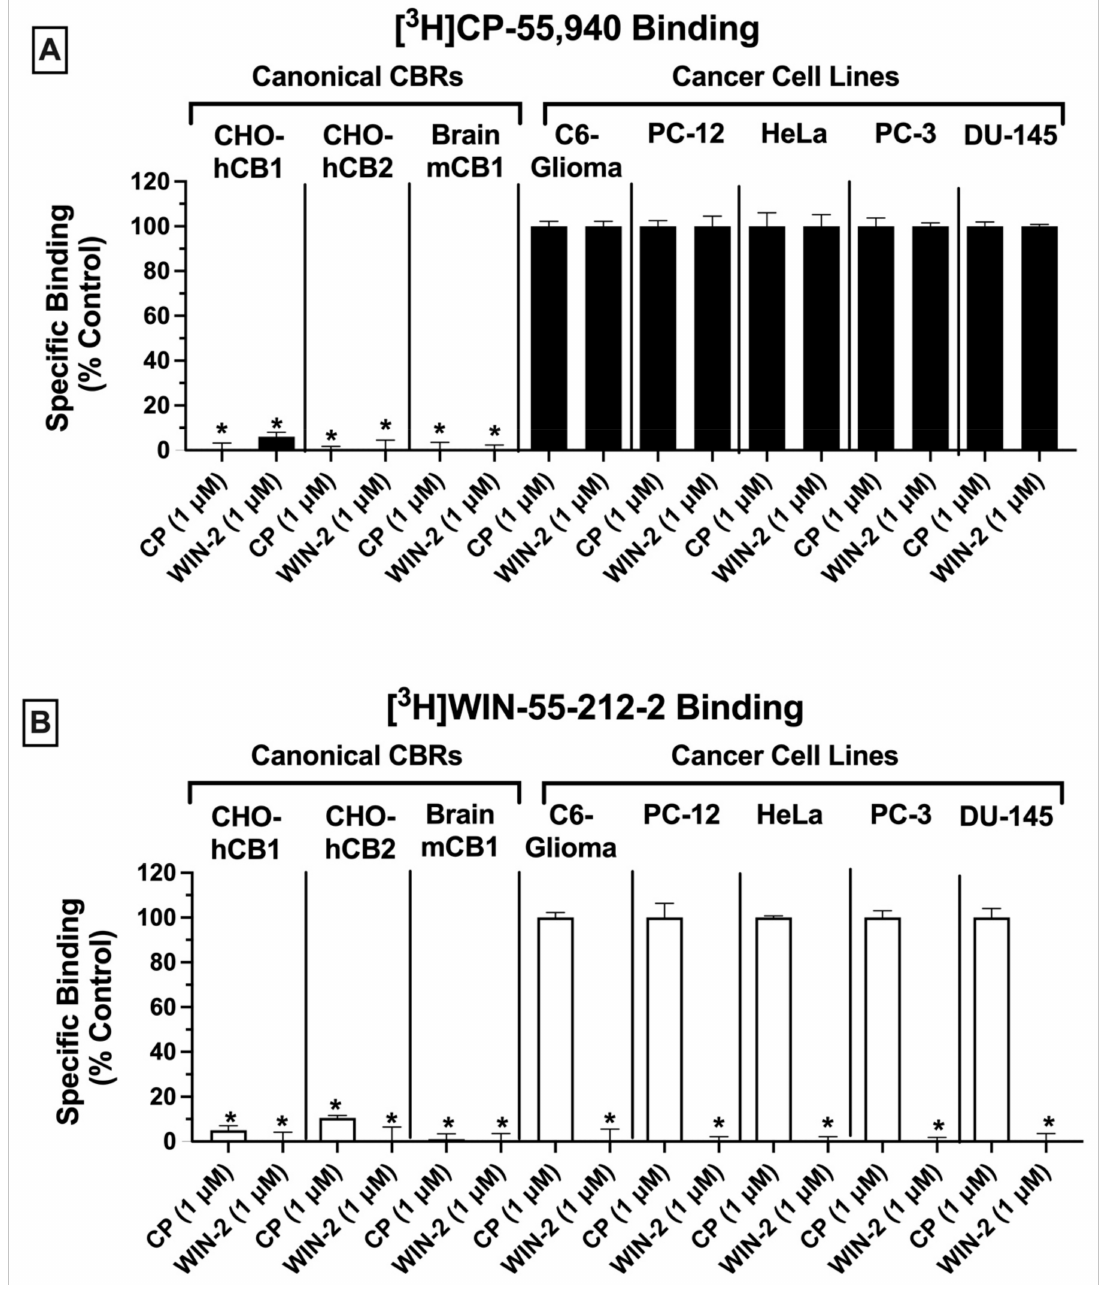
Figure 1. Competitive receptor binding: CBRs expressed in a variety of cancer cell types ex- hibit atypical binding properties relative to canonical CBRs. Competitive binding screens were conducted by using the well-characterized non-selective CB1/CB2 radioligands [ 3 H]CP-55,940 ing when radioligands were co-incubated with a high, receptor-saturating concentration (1 µ M) of non-radioactive CP-55,940 (left bars) or a second non-selective CBR ligand WIN-55,212-2